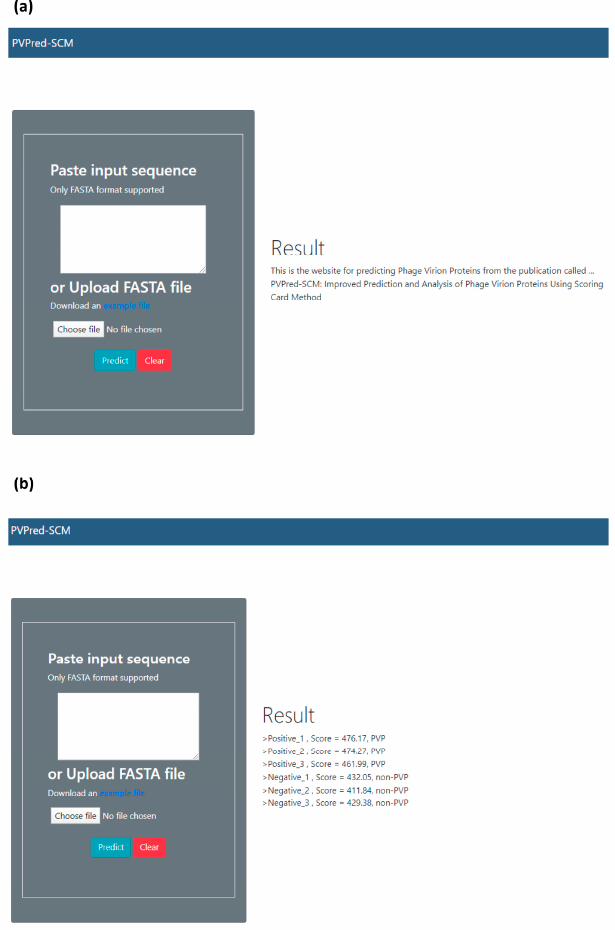
Figure 5. Screenshots of the PVPred-SCM web server before ( a ) and after ( b ) submission of a query protein. Prediction results are represented with the PVP scores derived from the scoring function (S(P)) and predicted classes.